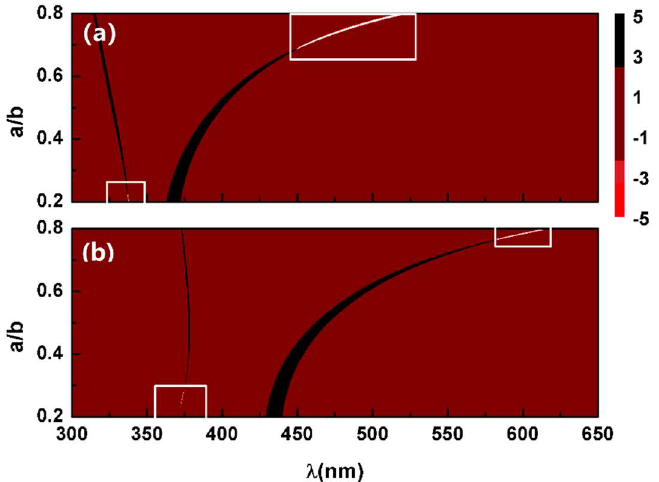
Figure 6. Normalized optical force, F / F 0 , versus incident wavelength, λ , and aspect ratio, a / b , in the cases of ( a ) h = 0 and ( b ) h = 0.3 with ε cg = − 0.07. The white curves indicate a pulling force much stronger than − 5, which is marked by a white rectangle.